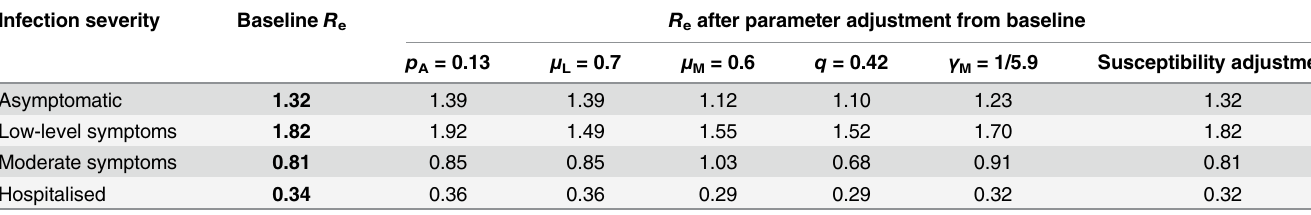
Table 2. Effective reproduction number by severity category and parameter values.